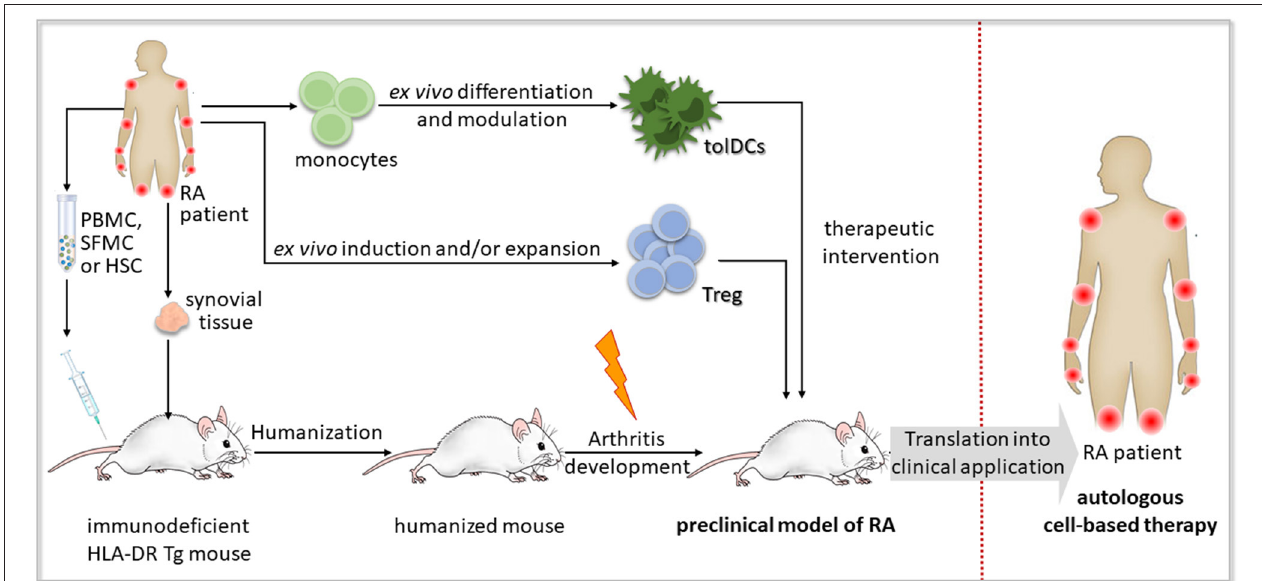
FIGURE 4 | Concept of preclinical testing of cell-based immunotherapy for rheumatoid arthritis in humanized mice. A humanized mouse model of rheumatoid arthritis (RA) could be established by the engraftment of human synovial tissue, hematopoietic stem and progenitor cells (HSCs), peripheral blood mononuclear cells (PBMCs) or synovial fluid mononuclear cells (SFMCs) from an RA patient bearing HLA-DR risk alleles such as HLA-DR*0401 or HLA-DR*0101 into immunodeficient mice expressing the respective transgenic (Tg) HLA-DR molecules. Autoimmune-like disease, if not developed spontaneously, might be induced by an additional trigger, such as RA-associated autoantigens or autoreactive T cell clones. The obtained humanized mouse model of RA enables preclinical testing of cell-based immunotherapeutic approaches applying autologous regulatory T (Treg) cells or tolerogenic dendritic cells (tolDCs) to recover self-tolerance, before their transfer to clinical application in RA